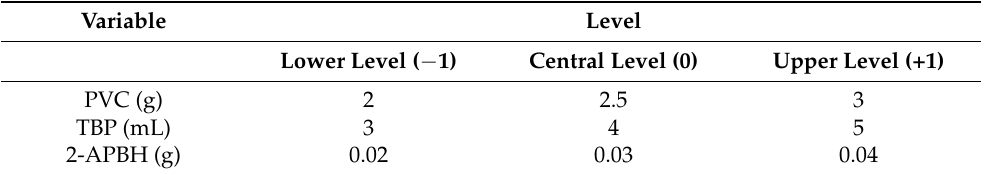
Table 1. Values of each level for the three variables studied.